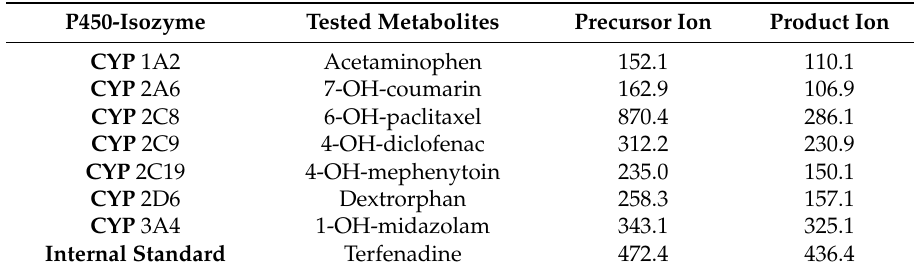
Table 3. Precursor-product ion pairs of CYP-specific metabolites for multiple reaction monitoring detection. P450-Isozyme Tested